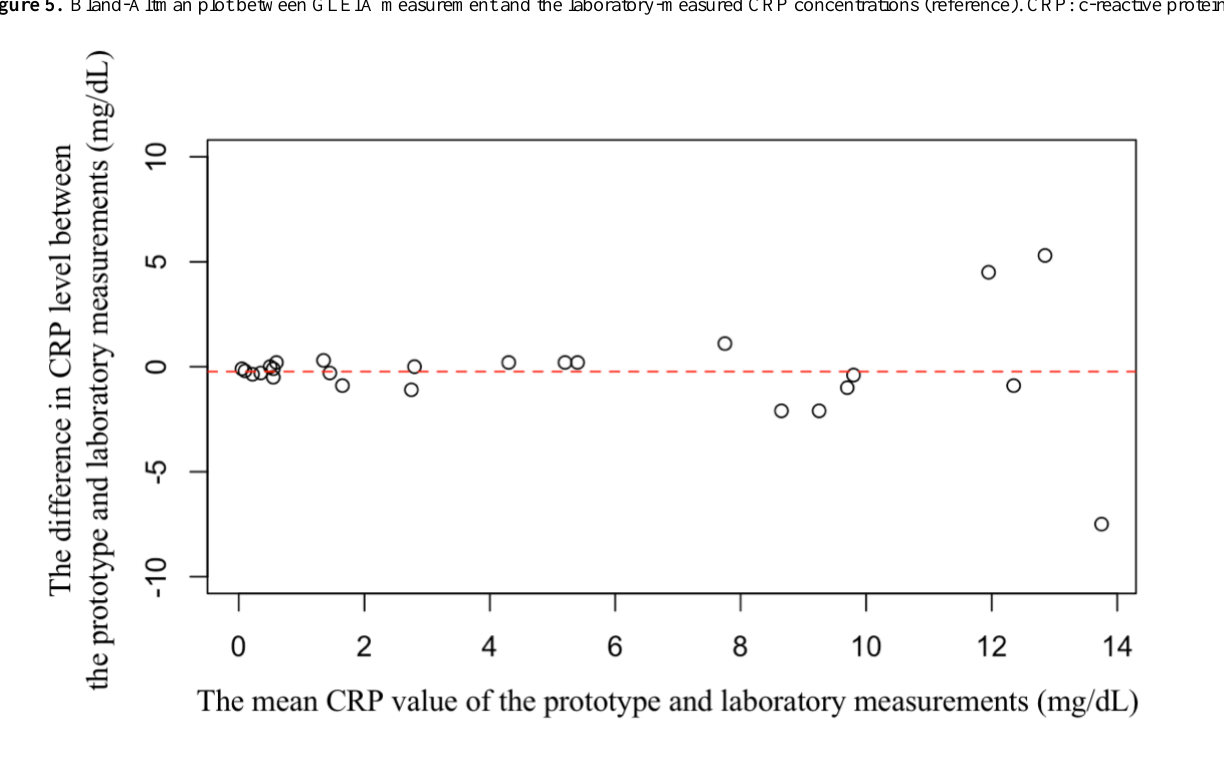
Figure 5. Bland-Altman plot between GLEIA measurement and the laboratory-measured CRP concentrations (reference). CRP: c-reactive